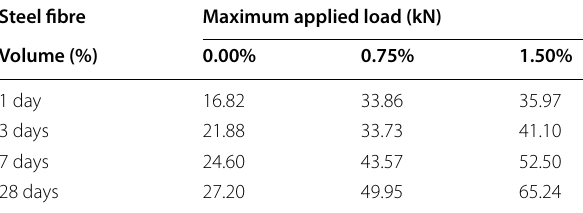
Table 4 Four-point flexural testing results